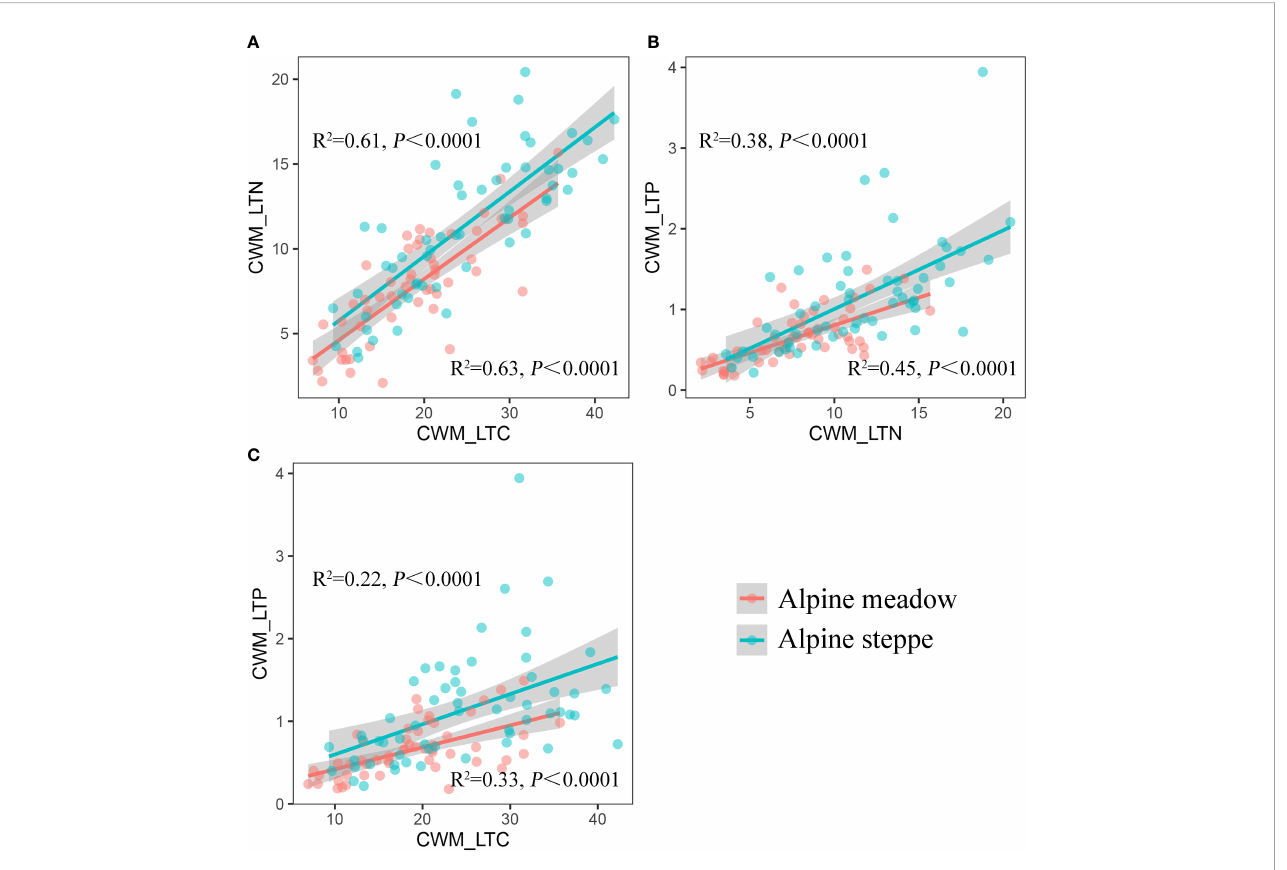
FIGURE 3 The linear fi ts of (A) CWM_LTN to CWM_LTC, (B) CWM_LTP to CWM_LTN, and (C) CWM_LTP to CWM_LTC. CWM_LTC, CWM_LTN, and CWM_LTP represent community-weighted mean of leaf total carbon, community-weighted mean of leaf total nitrogen, and community-weighted mean of leaf total phosphorus,